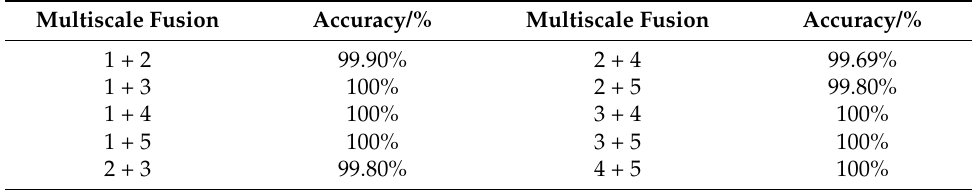
Table 3. Fusion results of different